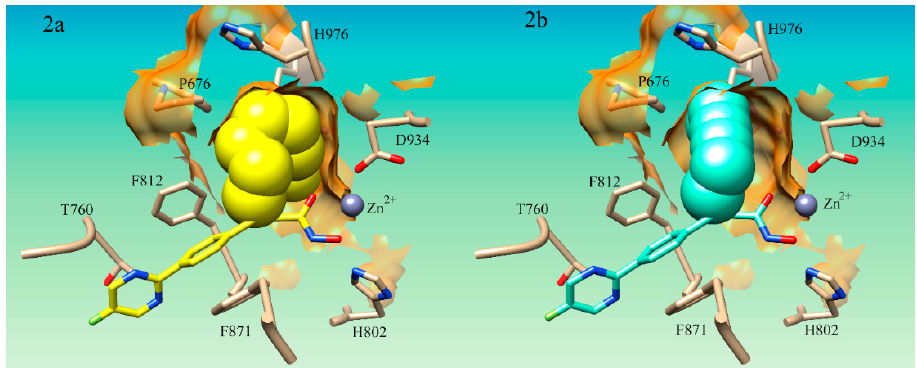
Figure 2. Docking pose of aliphatic compounds S25d-07 and S25d-03 in HDAC4 active site. ( 2a ) Compound S25d-07 (yellow) in HDAC4 active site; ( 2b )Compound S25d-03 (light cyan) in HDAC4 active site.